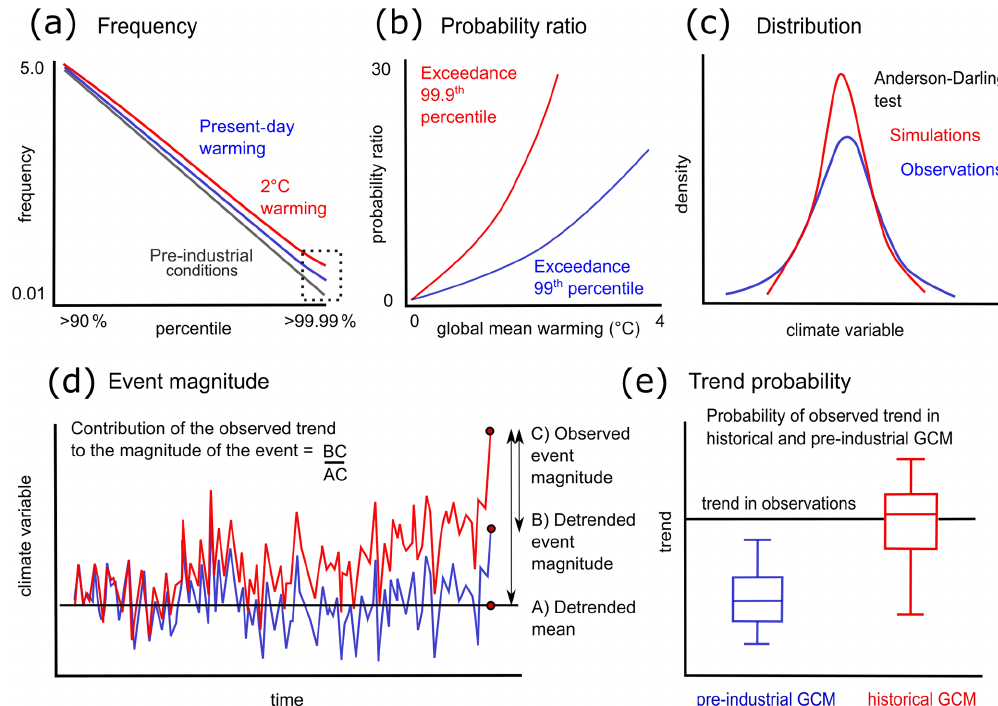
Figure 8. Attribution techniques for exploring nonstationarity with climate model simulations and observations. Panel (a) shows the fre- quency of daily precipitation in a given region for simulated pre-industrial conditions, present day and future warming scenarios. Panel (b) shows the probability ratio of exceeding the 99th / 99.9th percentile of pre-industrial temperature at a given warming level, relative to pre-industrial conditions and averaged across land. Panel (c) uses the Anderson–Darling test to evaluate differences between observed and simulated distributions. Panel (d) estimates the contribution of an observed trend to an event magnitude. Panel (e) estimates the probability of an observed trend in a historical climate model simulation. Panels (a) and (b) are simplifications of the general patterns shown in Fischer and Knutti (2015); panels (c) – (e) are adapted from Diffenbaugh et al.